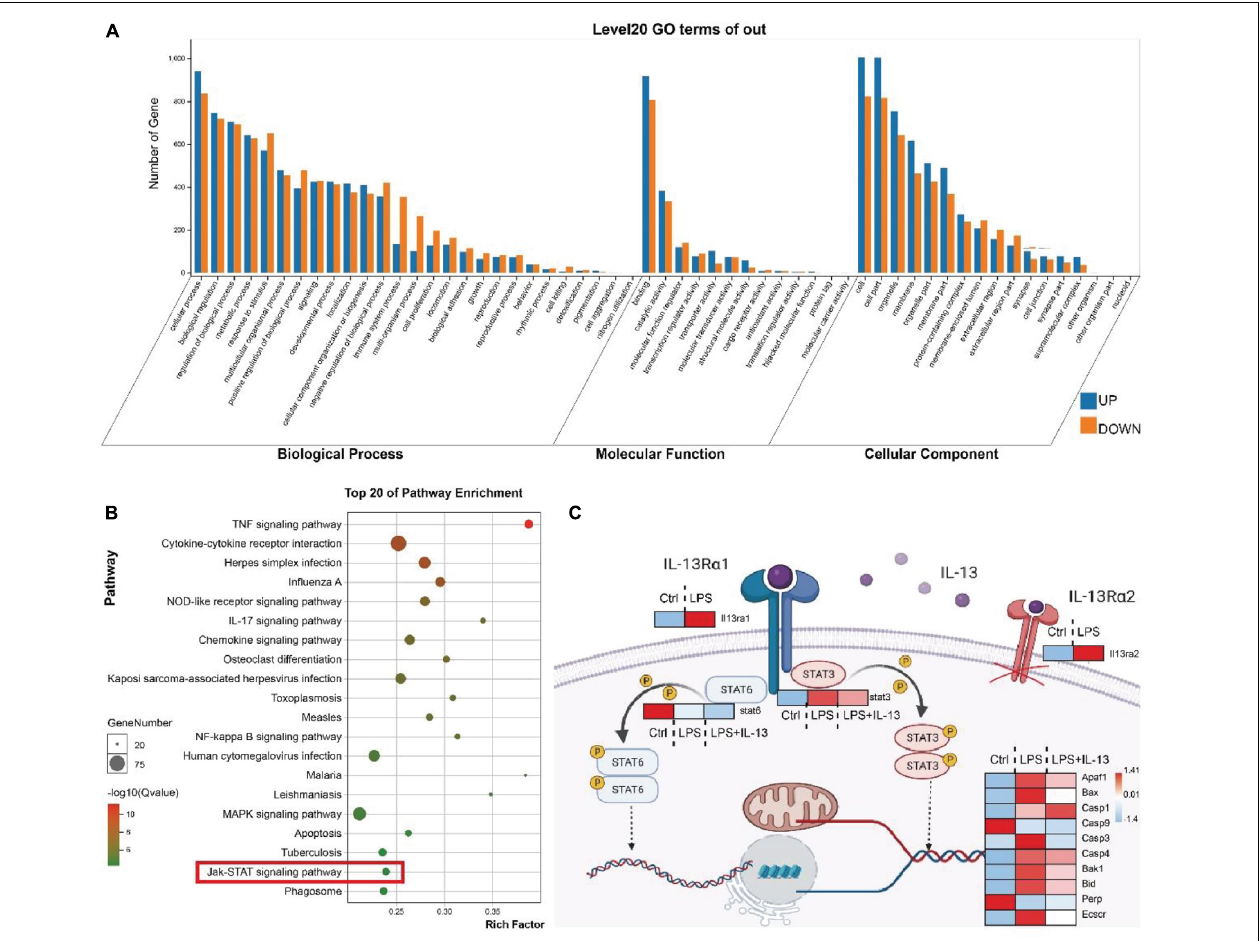
FIGURE 4 | The transcription level of STAT3 but not STAT6 was altered in the signaling pathway affected by IL-13. (A) GO analysis covered three domains including the biological process, molecular function and cellular component. The transcription of the heart tissue in mice receiving i.p. injection of LPS vs. control mice. (B) KEGG analysis revealed the most important signaling pathways involved in gene involvement. The transcription of the heart tissue of mice receiving i.p. injection of LPS vs. control mice. (C) Illustration of the downstream key genes in the heart tissue regulated by IL-13 as shown by RNA sequencing (RNA-seq). Data are presented as heatmap (log 2 -fold change). Red indicates higher expression, and blue indicates lower expression ( n =